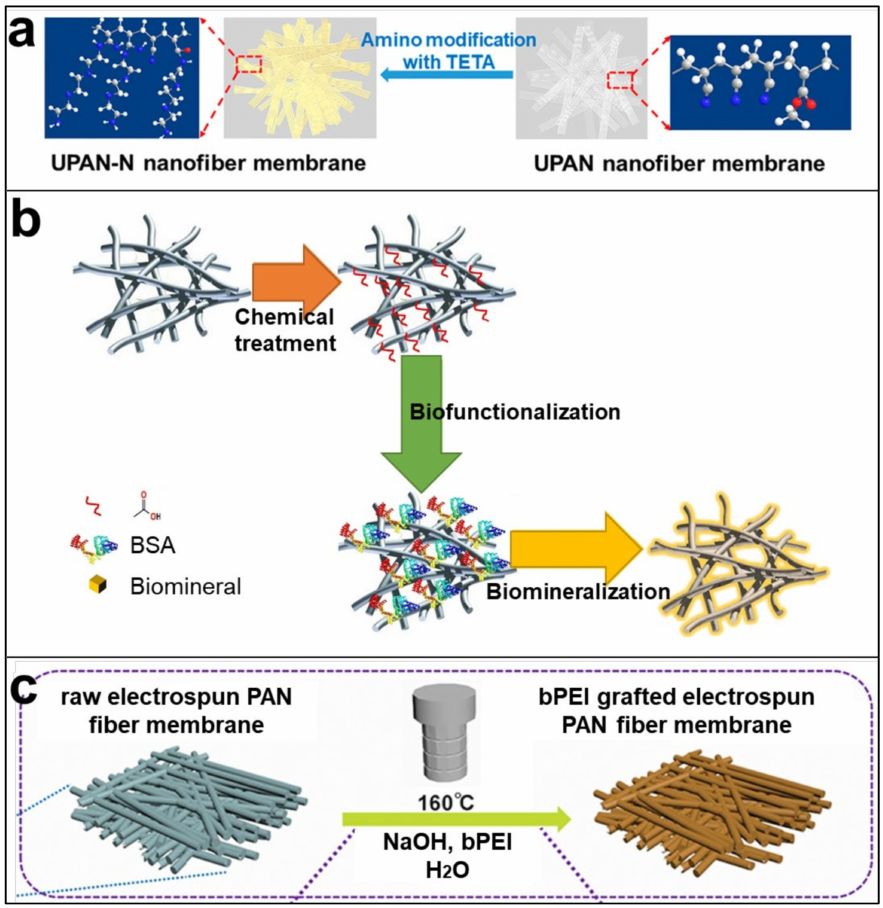
Figure 7. Schematic diagram of the three methods of PAN nanofiber surface modification. ( a ) Schematic of the process of chemically modifying the surface of PAN nanofibers with TETA, Reprinted with permission from [150], copyright 2022, American Chemical Society. ( b ) Schematic diagram of the biomineralization process of PAN nanofibers, Reprinted with permission from [156] copyright 2020, Elsevier. ( c ) Schematic diagram of the whole process of preparing bPEI grafted PAN nanofibers by electrospinning technology and green hydrothermal reaction, Reprinted with permission from [160] copyright 2018,